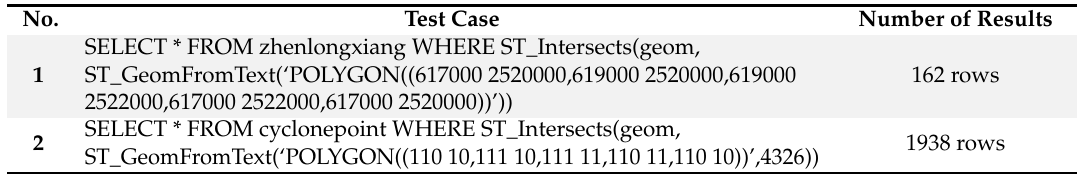
Table 10. Test cases of window queries.